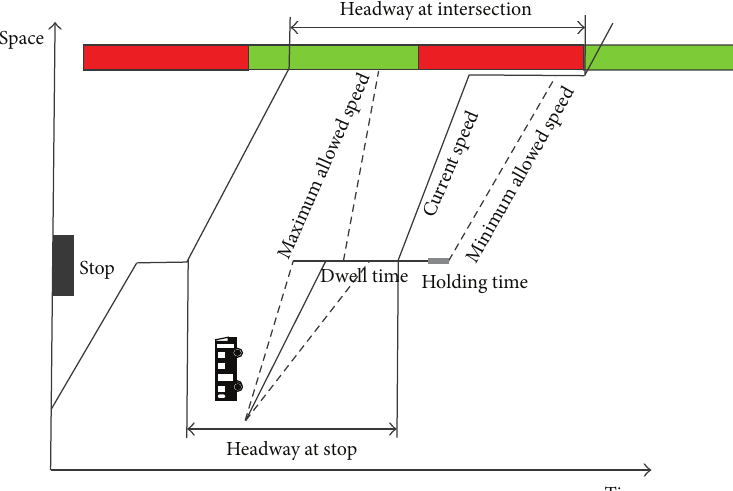
Figure 4: Speed adjustment